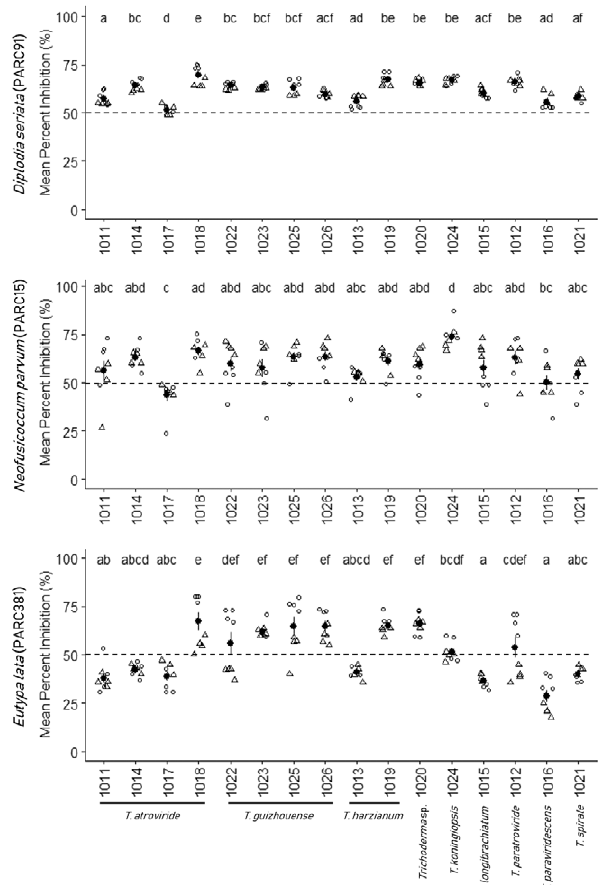
Figure 6. Mean percent inhibition of radial growths (PIRG) for Trichoderma isolates from southern Italy against GTD pathogens Diplodia seriata PARC91, Neofusicoccum parvum PARC15 and Eutypa lata PARC 381, measured after 5 d. White dots and triangles represent, respectively, data from experiment 1 and repeated experi- ment 2. Solid black dots represent the mean percent inhibition for each isolate calculated from eight replicates, and bars represent standard errors of the means. Dash line represents 50% inhibition threshold. Columns accompanied by the same letter were not statis- tically different ( P = 0.05), Tukey-Kramer Honest Significant Differ- ence post-hoc